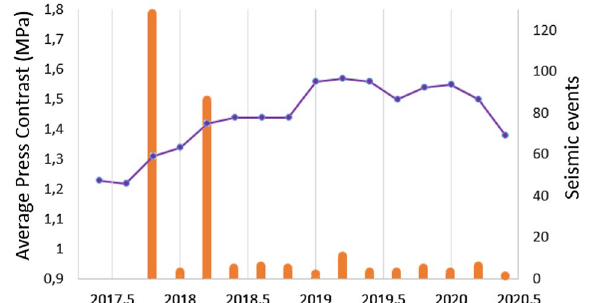
Figure 5. 2017–2020 average pressure time evolution for the adjusted sources. Adjusted average pressure per volume unit (blue color) and the number of seismic events (orange columns) between February 2017 and June 2020. During the October 2017 seismic swarm 122 events took place with a magnitude lower than 3 and the 95% of them with magnitude between 1 and 2. During the February 2018 seismic swarm 79 events took place with magnitude lower than 3 and the 77% of them with magnitude between 1 and 2. This figure was created using Microsoft Excel 2016.